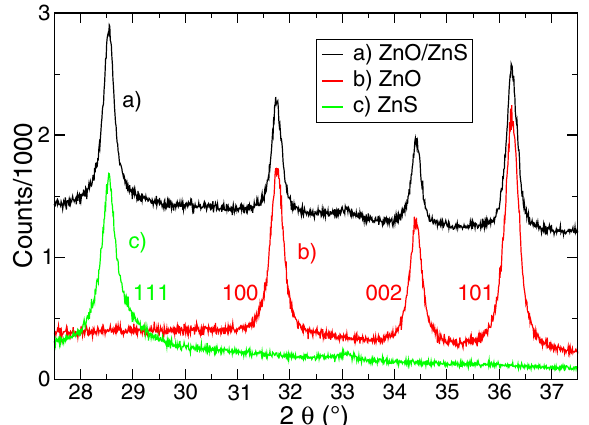
Fig. 1. XRD patterns of powder samples prepared from ZnO, ZnS and ZnO/ZnS sputtering targets. Miller indices are shown assuming hexagonal symmetry (wurtzite) for ZnO and cubic symmetry (zinc blende) for